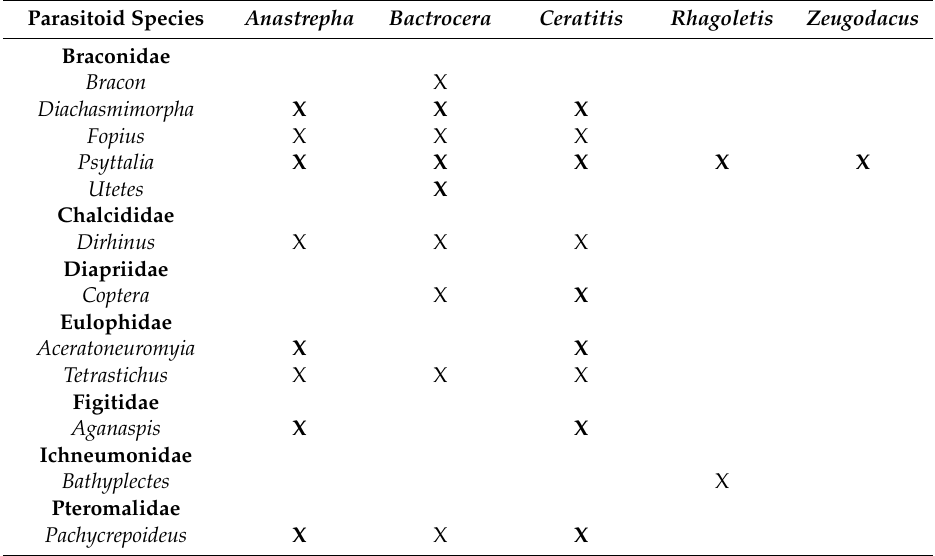
Table 5. Association between genera of introduced parasitoids (Hymenoptera) with the genus of fruit flies with economic importance in the Americas and